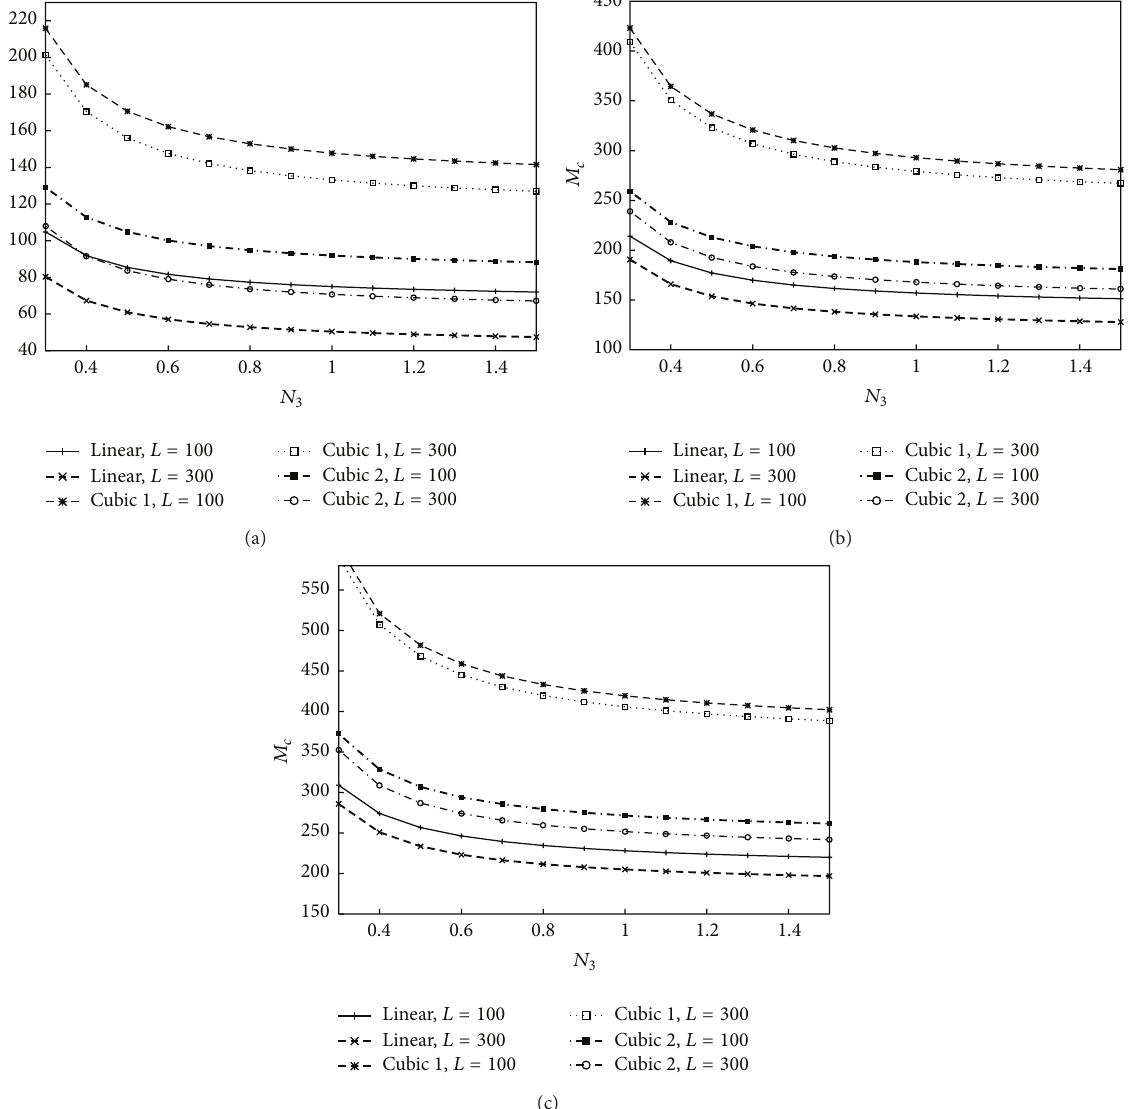
Figure 3: Plot of critical Marangoni number, 𝑀 𝑐 , versus couple stress parameter, 𝑁 3 , for different electric number, 𝐿 , and (a) 𝐾 = 0 , (b) 𝐾 = 4 , and (c) 𝐾 = 8